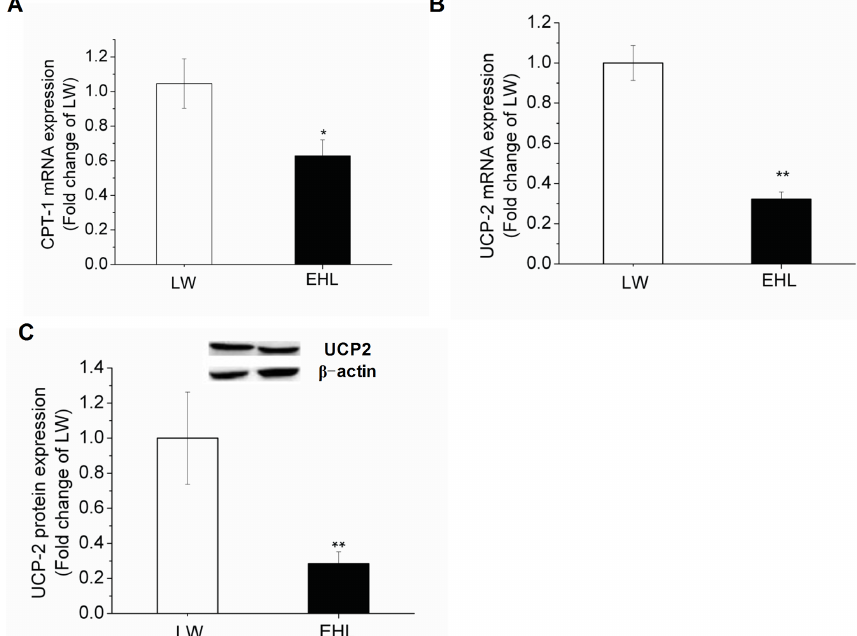
Figure 3. mRNA and protein expression of genes related to energy metabolism in the subcutaneous fat of LW and EHL pigs. (a) CPT1 mRNA expression, (b) UCP2 mRNA expression and (c) UCP2 protein expression. The values shown represent the mean ± standard error, n = 6; * P <0.05 vs. LW; ** P <0.01 vs.